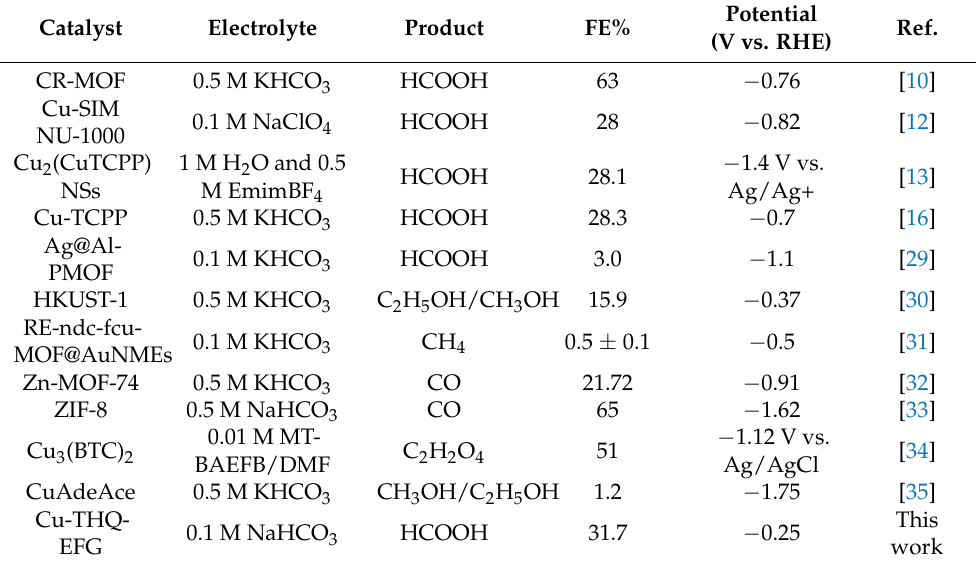
Table 1. Comparison of the CO 2 RR performance with previously reported MOFs.